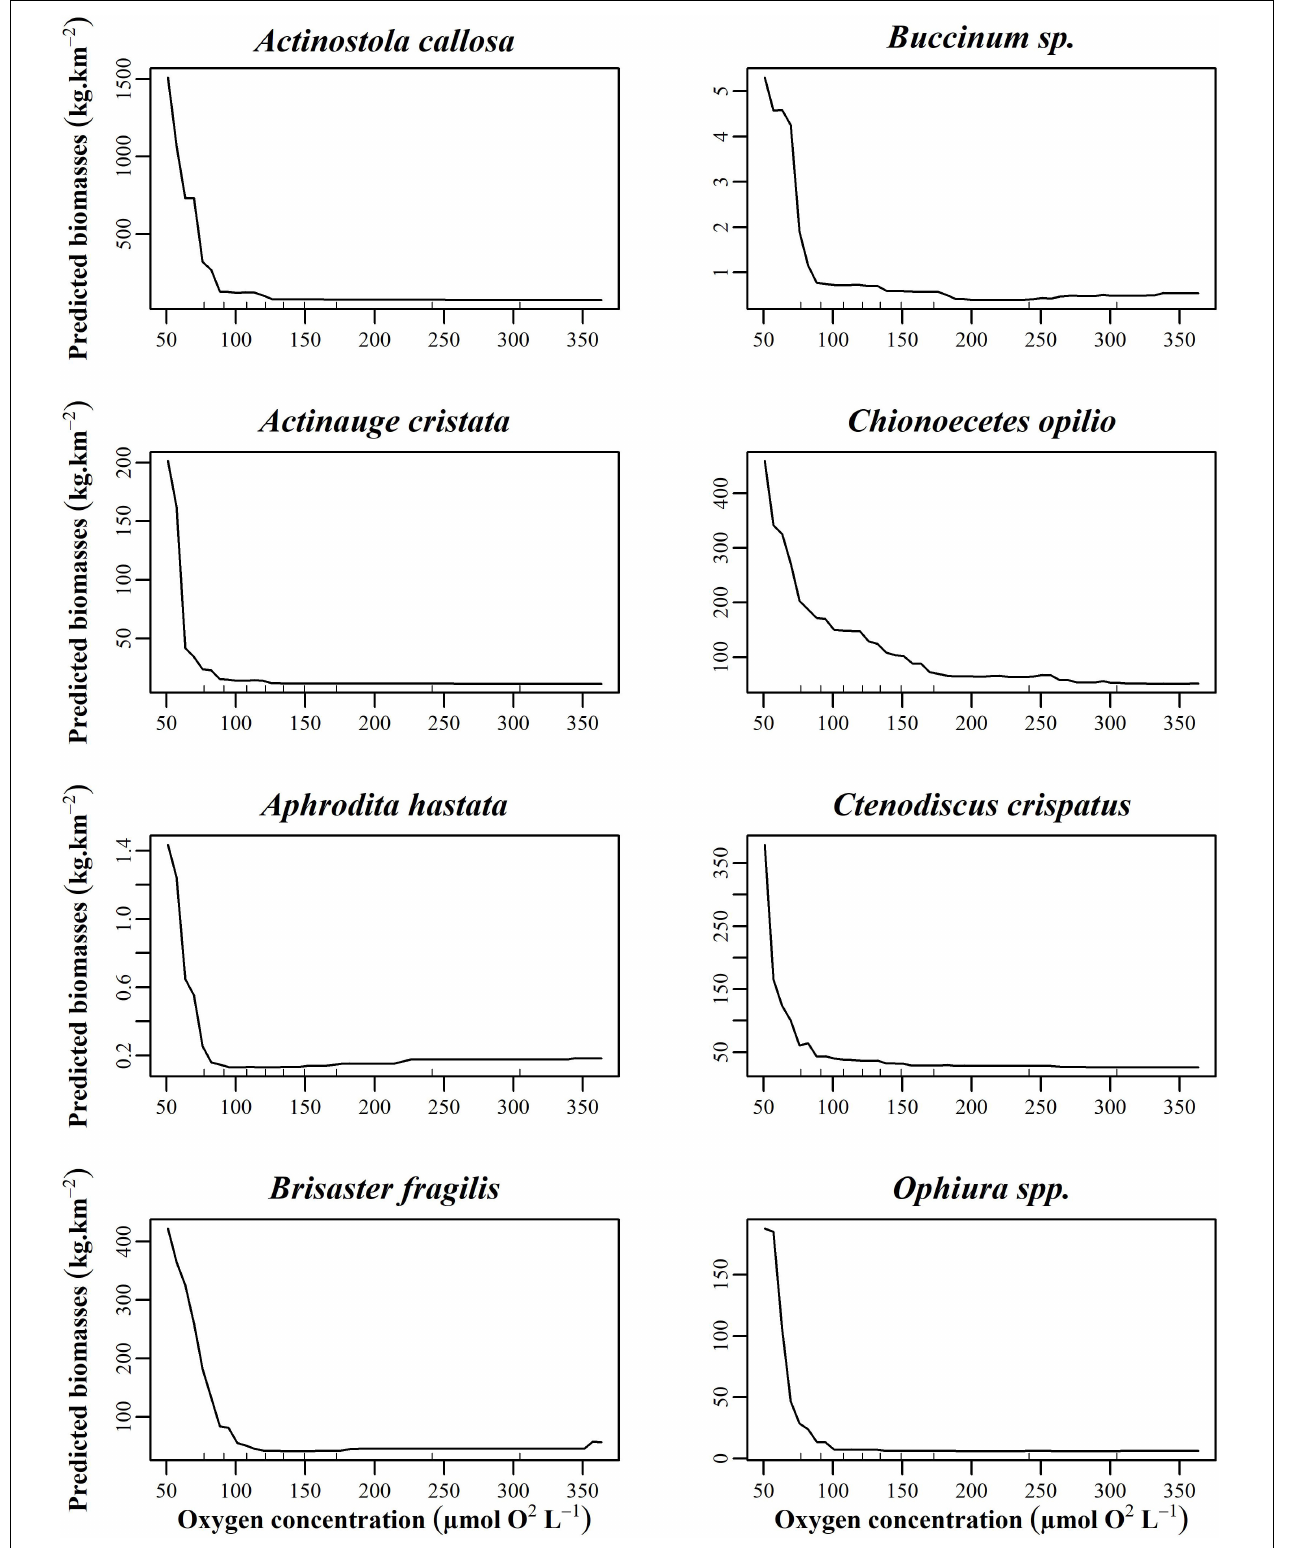
FIGURE 6 | Partial dependence plots of the top eight taxa with the highest R 2 at the 50–100 µ mol O 2 L - 1 threshold build from the random forest biomass regressions of taxa for oxygen.